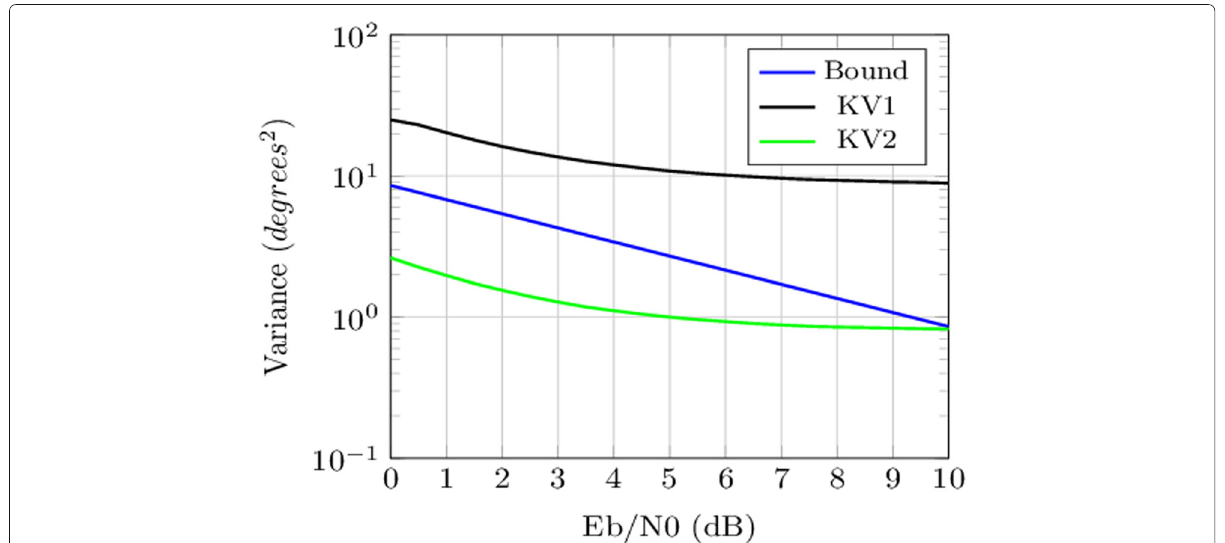
Fig. 12 Performance of our carrier recovery sub system. Estimated phase’s variance analyzing two different scenarios